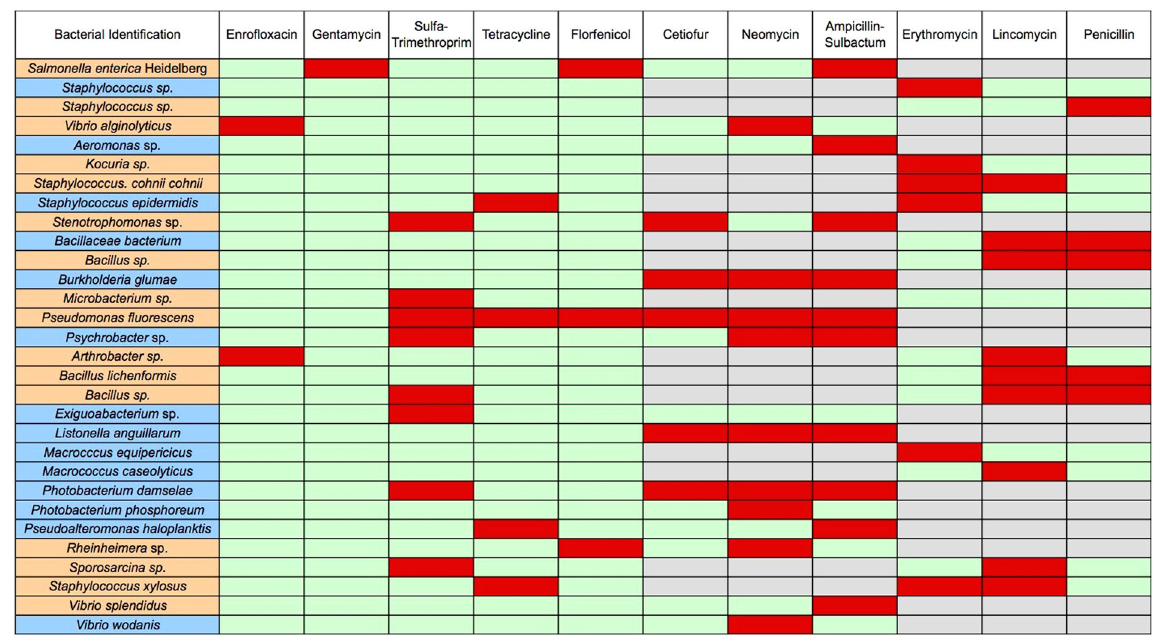
Figure 3. Heat map of antibiotic resistance detected in breath and SML bacteria. Bacterial names in orange boxes are from exhaled breath samples, and names in blue boxes are from SML samples. Matrix cells in red signify resistance, matrix cells in green signify sensitivity, and matrix cells in gray indicate no testing because the antibiotic is not appropriate for the